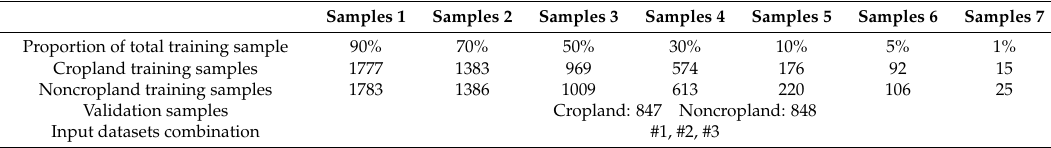
Table 2. The design of the experiment for assessing the influence of the size of training samples for synergy cropland mapping. The cropland maps used are Unified Cropland (#1), GlobeLand30 (#2), and NLUD-C (#3).